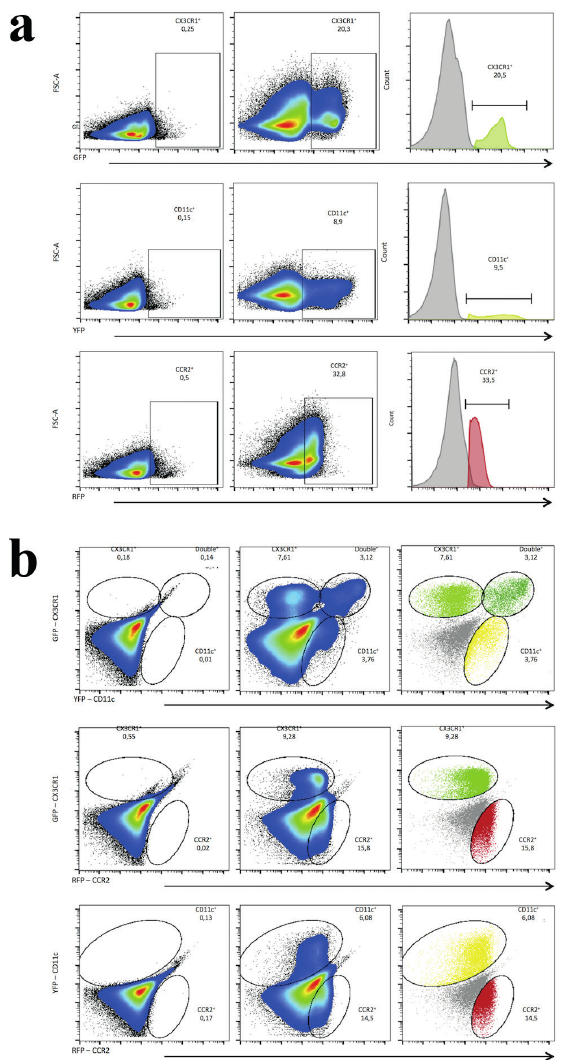
Figure 5 - Efficient flow cytometry separation of liver leucocytes from triple fluorescent mouse CX3CR1 gfp/wt CCR2 rfp/wt CD11c- eYFP. ( a ) Individual visualization of GFP fluorescence (FL1 channel – filter 510/15nm), YFP (FL2 – filter 540/20nm) and RFP (FL3 – filter 610/20nm) on Accuri C6 (BD Biosciences) cytometer of triple fluorescent mice compared to WT animals. ( b ) Simultaneous expression of CX3CR1, CD11c and CCR2 evidencing individual populations of each receptor and the presence of double-positive cells for CX3CR1 and CD11c. CCR2+ cell populations do not express CX3CR1 neither CD11c in homeostatic